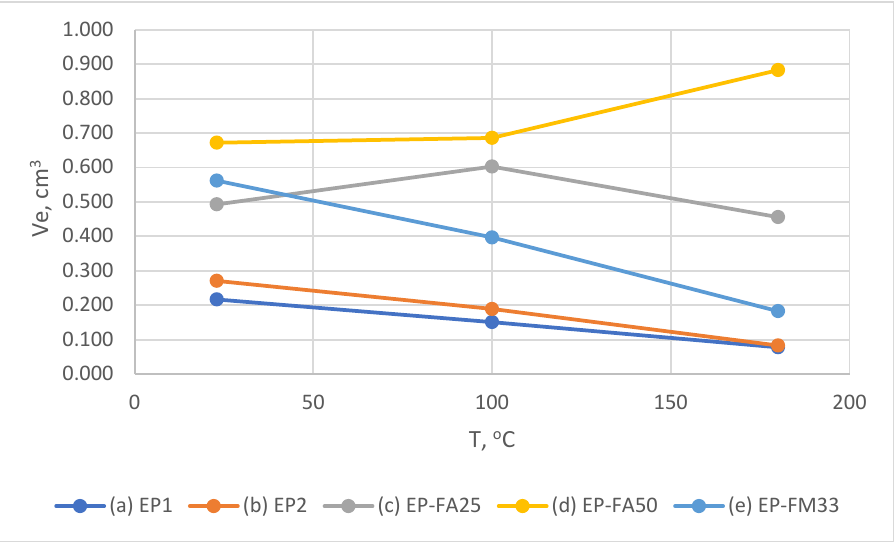
Figure 10. Dependence of the wear of unfilled and filled compounds on temperature at an impinge- ment angle of 45°